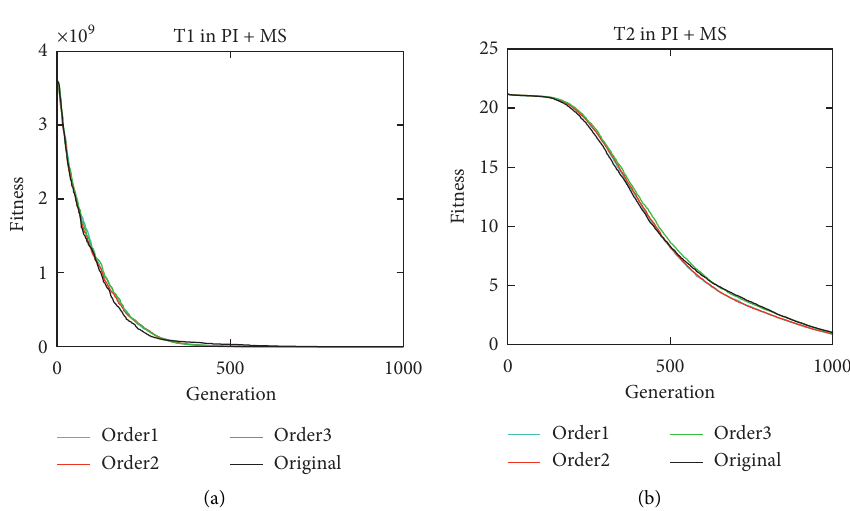
Figure 17: Convergence of MFDE for problem 5 (PI+MS).